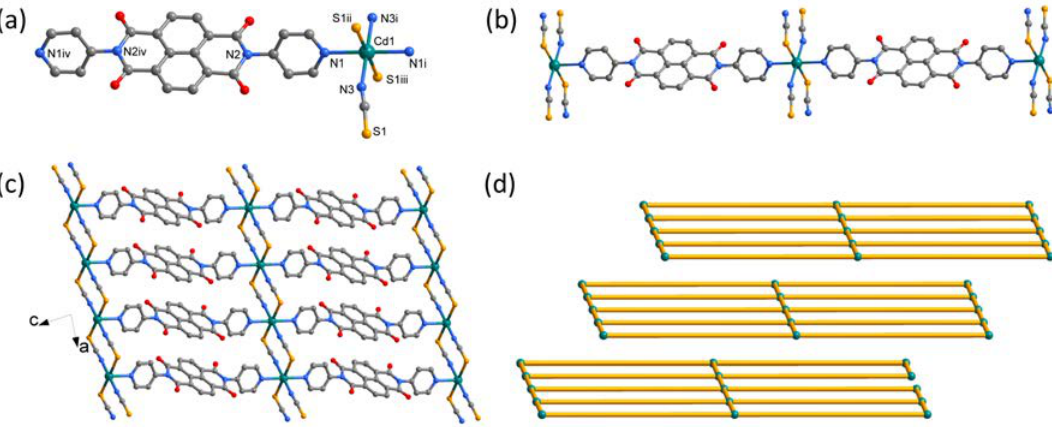
Figure 2. ( a ) The coordination environment of the Cd atom in 2 , symmetry codes: (i) 1 – x, –y, –z; (ii) –1 + x, y, z; (iii) 2 – x, –y, –z; (iv) –x, 1 – y, 1 – z; ( b ) the one-dimensional coordination configuration; ( c ) the two-dimensional framework view along the ac plane; and ( d ) the topological structure of 2 . All hydrogen atoms are omitted for clarity.